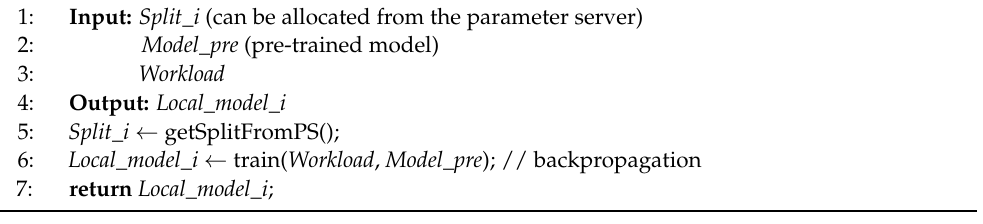
Algorithm 2. Partitioning Algorithm for Edge Server i .